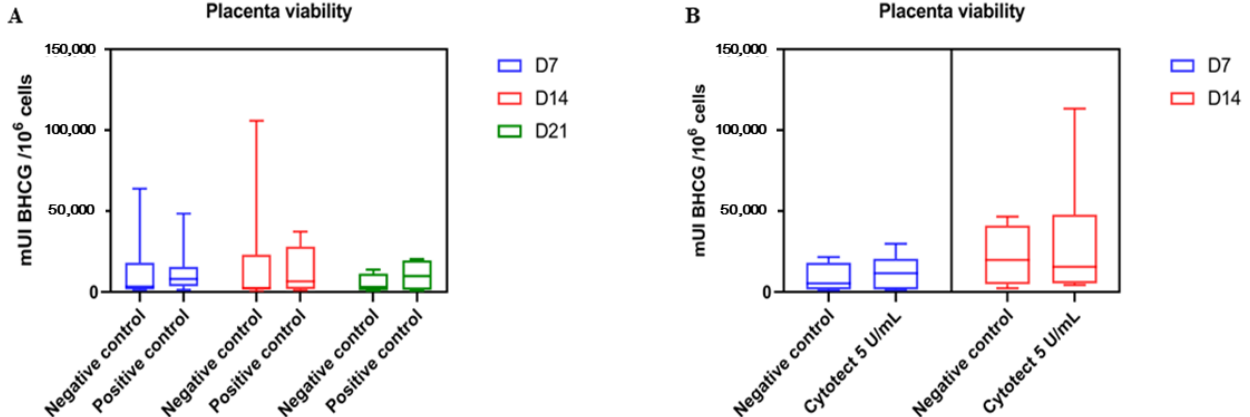
Figure 8. Placenta viability. ( A ) Comparison of β -hCG levels between the negative control villi and villi infected with TB40E without Cytotect CP ® after 7, 14, and 21 days of infection. ( B ) Comparison of β -hCG levels from the negative control villi and villi with only Cytotect CP ® after 7 and 14 days of exposure to the maximum tested dose. The boxplots are designed as medians (Q2), lower quartiles (Q1), and upper quartiles (Q3). The whiskers are extended to the extreme data points.